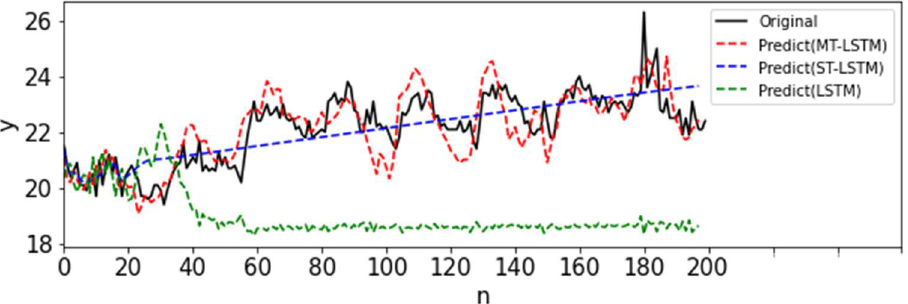
Figure 11. Prediction results of MT-LSTM, ST-MTGP, and LSTM for the extreme situation.